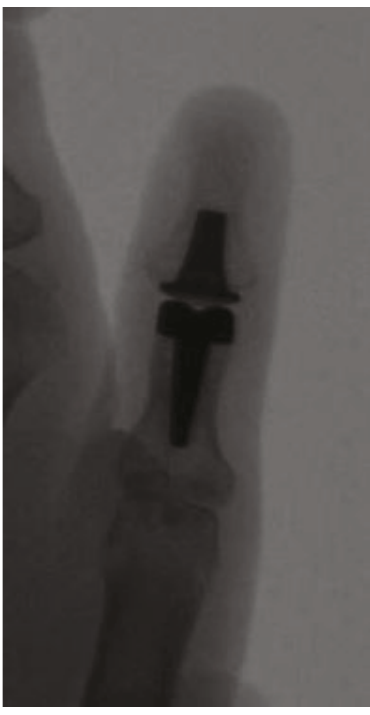
Figure 3: AP view of the thumb IP joint with the implant in place.